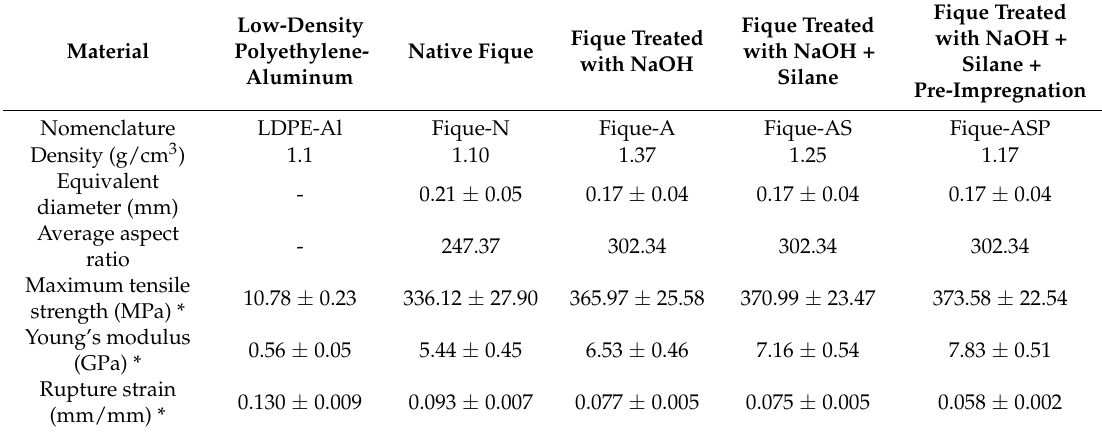
Table 1. Physical-mechanical properties of the materials used in the preparation of the